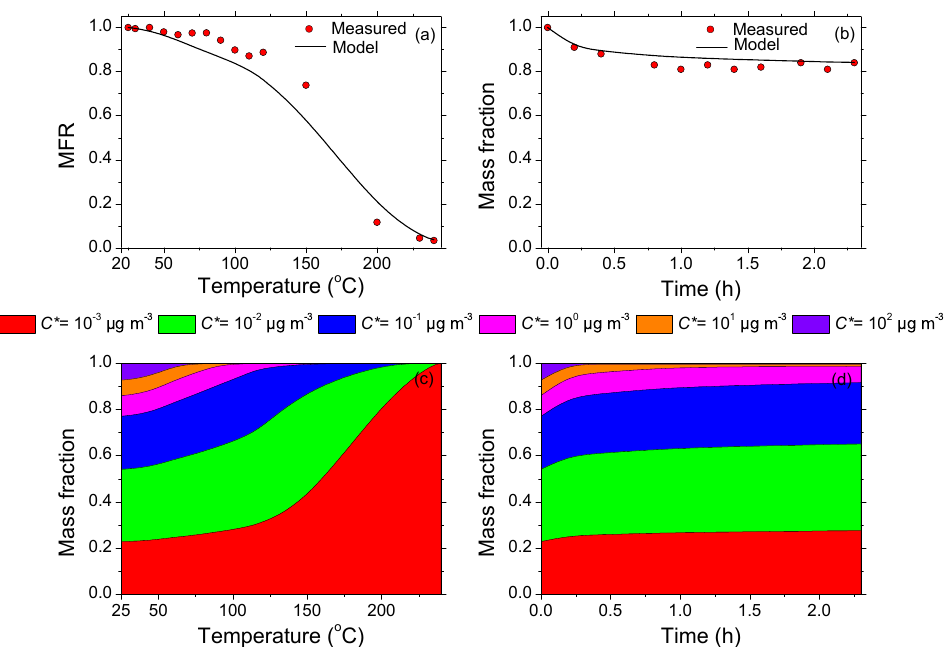
Figure 6. (a) Thermogram of the OA TD measurements of Experiment 2. Red circles represent the loss-corrected measurements and the black line represents the best fit estimated by the model of Karnezi et al. (2014). (b) Mass fraction during isothermal dilution as a function of time of Experiment 2. Red circles represent the loss-corrected measurements and the black line is the estimated best model fit. (c) COA mass fraction for different effective saturation concentrations as a function of TD temperature. Red represents the contribution of the effective saturation concentration C ∗ = 10 − 3 µgm − 3 , green the contribution of the C ∗ = 10 − 2 µgm − 3 , blue the C ∗ = 10 − 1 µgm − 3 , magenta the C ∗ = 1µgm − 3 , orange the C ∗ = 10µgm − 3 , and violet the C ∗ = 10 2 µgm − 3 . (d) COA mass fraction for different effective saturation concentrations as a function of time during isothermal